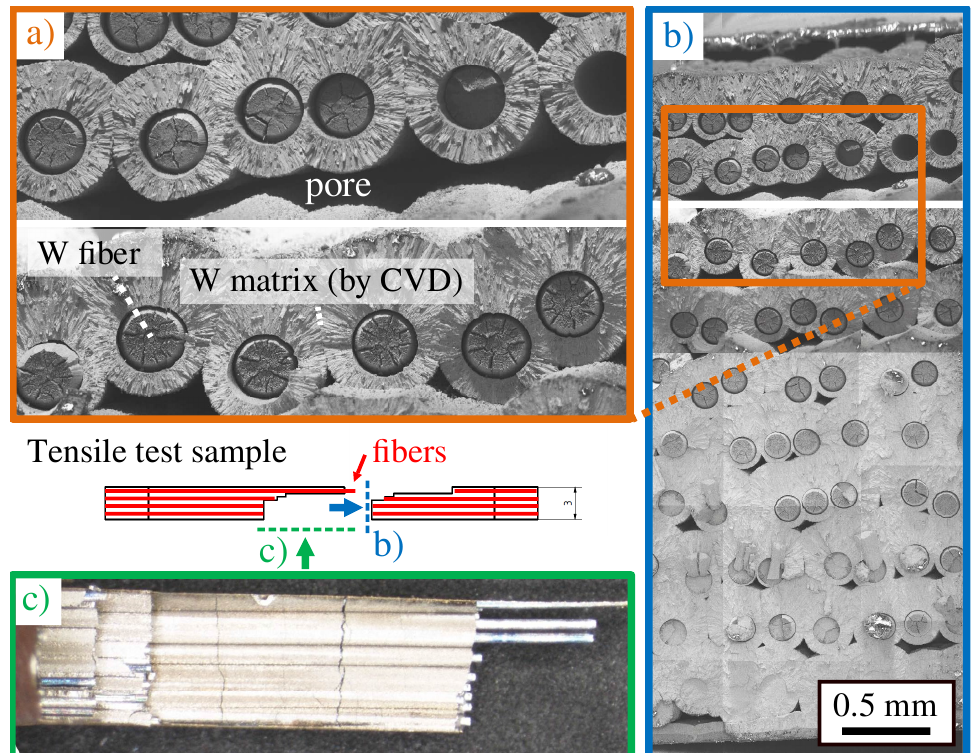
Figure 2. Fracture surface of a W f /W tensile test specimen delaminated due to large pores, with ( a ) being a close-up of ( b ), with ( b ) being a SEM image perpendicular to the warp fiber axes, and with ( c ) being a photo perpendicular to a delaminated layer. The viewing angles are sketched in the center. Details can be found in